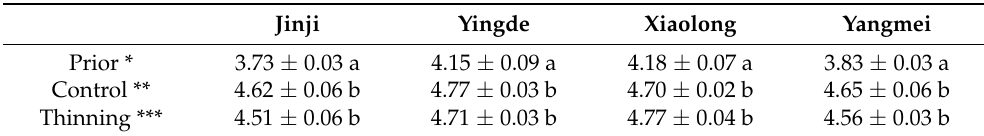
Table 4. Mineral soil pH values (means ± standard errors) of different forest managements in different study sites, in 2020 and 2021. Different letters indicate significant differences between different years, and between different treatments in 2021 ( p < 0.05). * n = 18, samples taken before thinning applied; ** n = 9, samples taken from control plots; *** n = 9, samples taken from thinning plots. Jinji